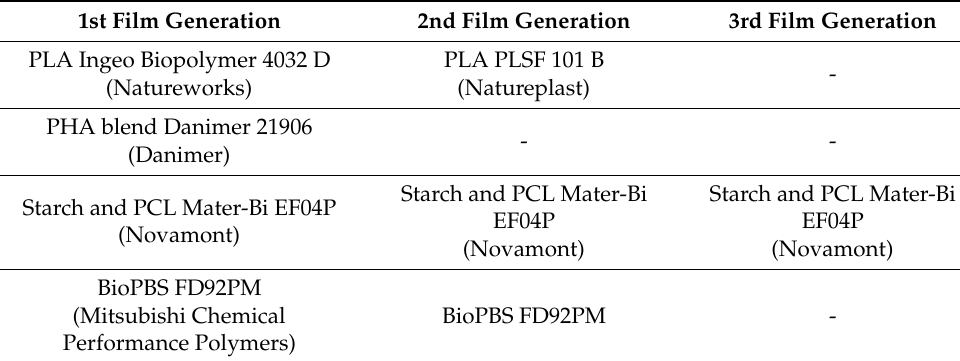
Table 2. Polymers selected for each film generation.